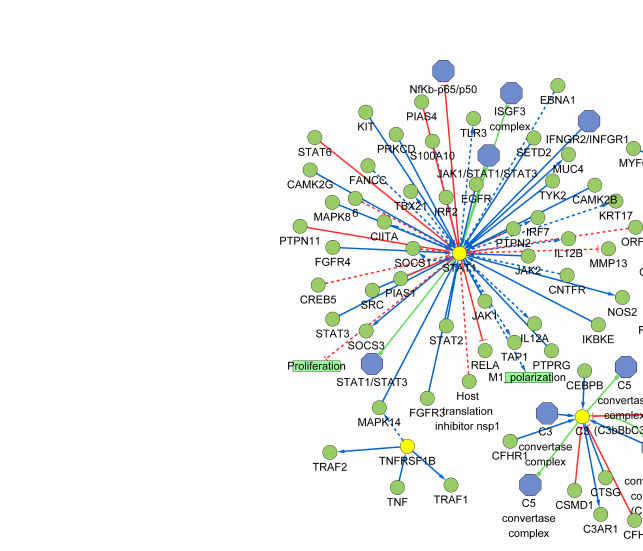
FIGURE 10 Signaling information network of the hub genes based on SIGNOR.